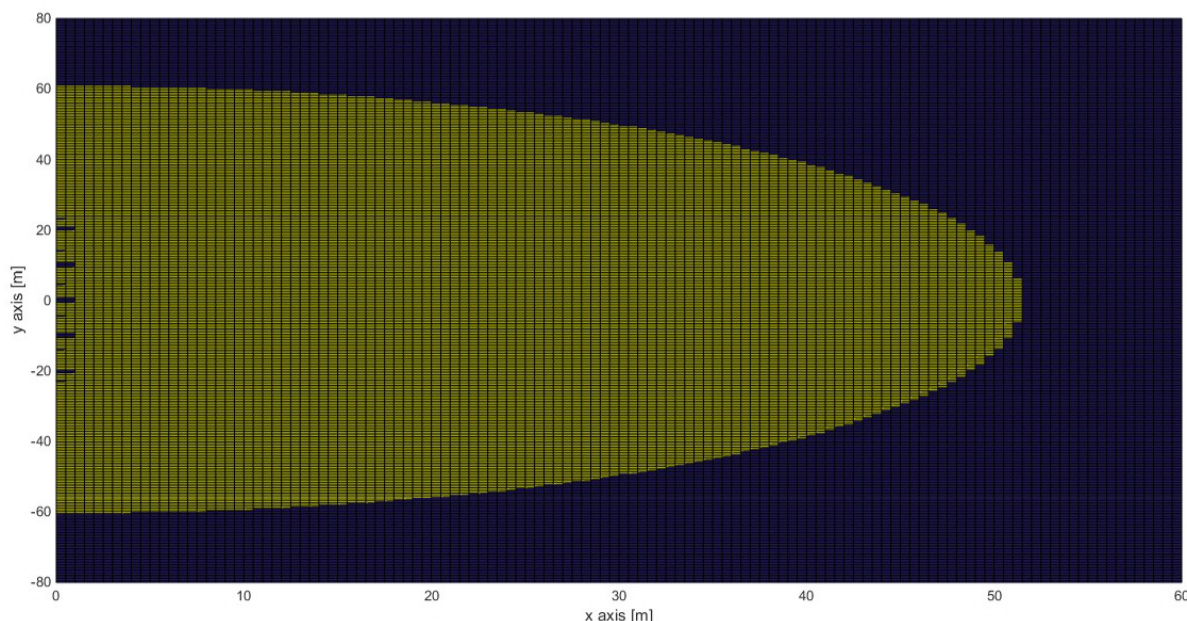
Figure 26. Area of electric field strength, with values higher (yellow) and lower (blue), than the limit of 1.25 V/m, for method “C”, of linear current source, for an electrode station of 6 linear frames in a row with d frames = 6.50 m; each frame consists of 13 electrodes of active length L = 2.13 m, D el = 0.50 m, ρ w = 0.25 Ω · m, θ = 248 ◦ (area of Korakia), J full_load_steady = 18.33 A/m 2 (steady state and operation of all 6